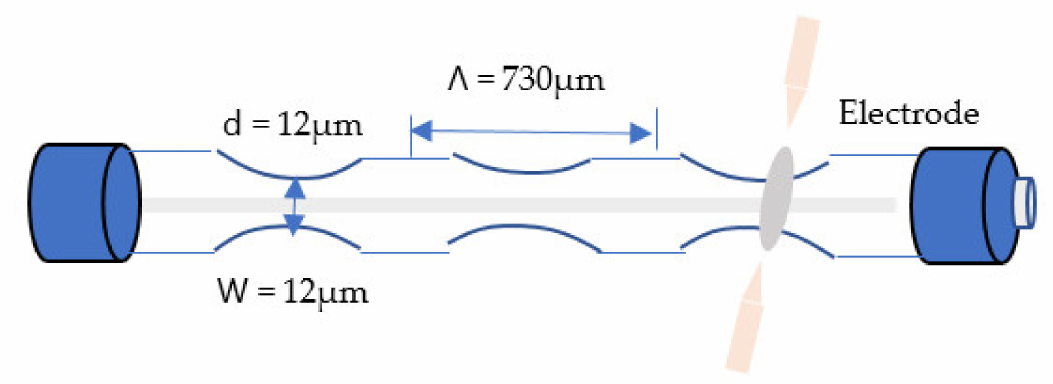
Figure 4. Tapered fiber optic based on long-period fiber grating (LPFG) structure